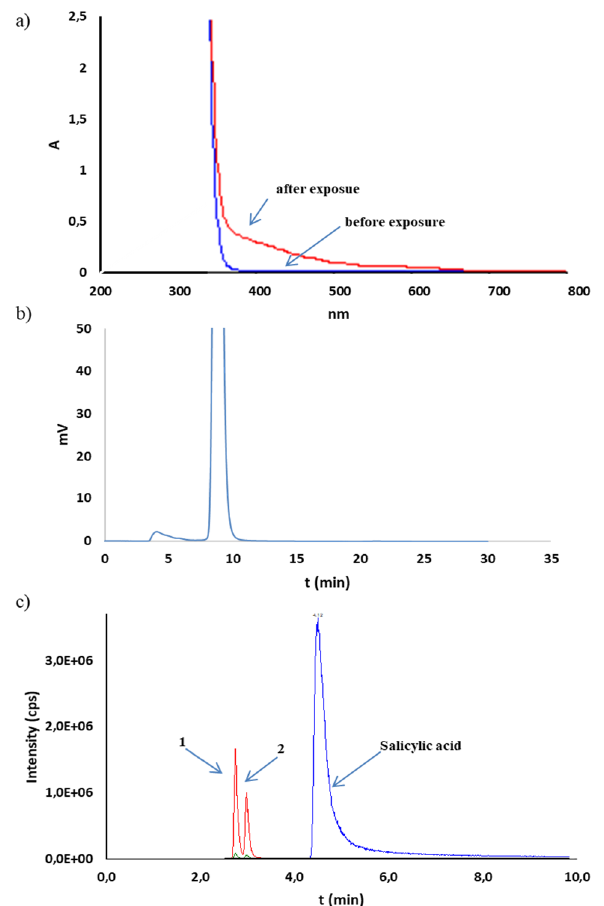
Figure 6. UV ( a ), HPLC-UV ( b ), and HPLC-MS/MS ( c ) analysis of sodium salicylate solution (13 mg/mL) subjected to photodegradation (1.2 · 10 6 lux · h). 1—2,5-dihydroxybenzoic acid; 2—2,3-dihydroxybenzoic acid.